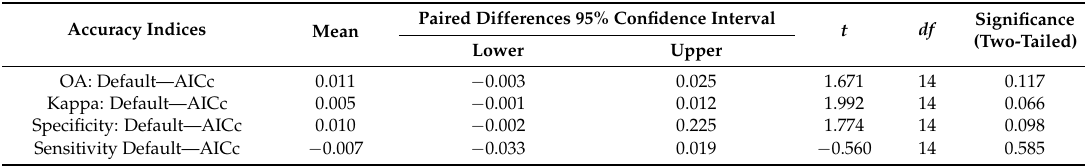
Figure 4. The performance comparison of the Maxent-DPS model and the Maxent-AICc model with four evaluation indicators (Kappa, overall accuracy, specificity, sensitivity). The line chart on the left and the box plot on the right specific and overall performance of the Maxent-DPS model and the Maxent-AICc model under the 15 schemes (January–December, NDVI, TS-1, TS-2), respectively. Table 6. Paired t -test for five pairs of accuracy indices ( p = 0.05). Accuracy indices (kappa, overall accuracy, sensitivity, specificity, omission) of the Maxent-AICc model and Maxent-DPS model under the 15 schemes of Setups 1–3.